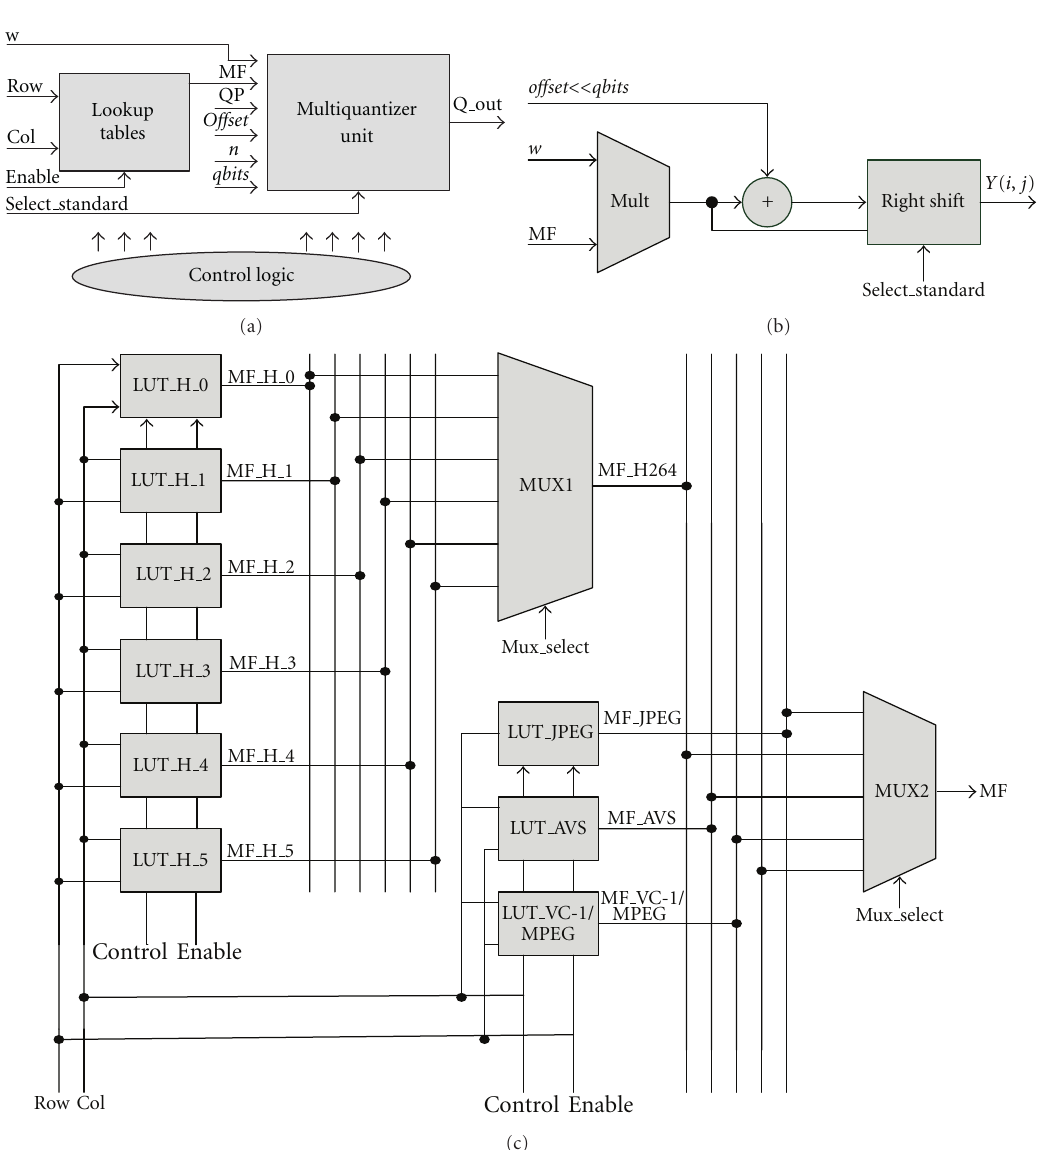
Figure 4: (a) Overall block diagram of the proposed architecture, (b) core unit with a multiplier, and (c) lookup tables and data flow